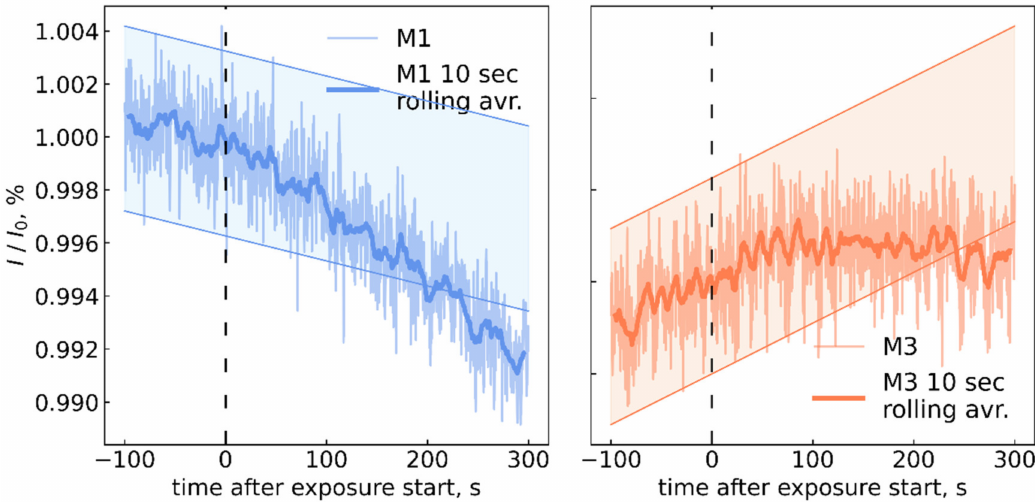
Figure 14. Fluorescence response of materials M1 and M3 to NB vapors at 1 ppm